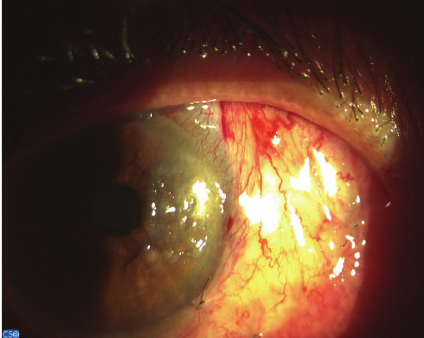
Figure 3: The wide conjunctival flap technique was performed in the first week after